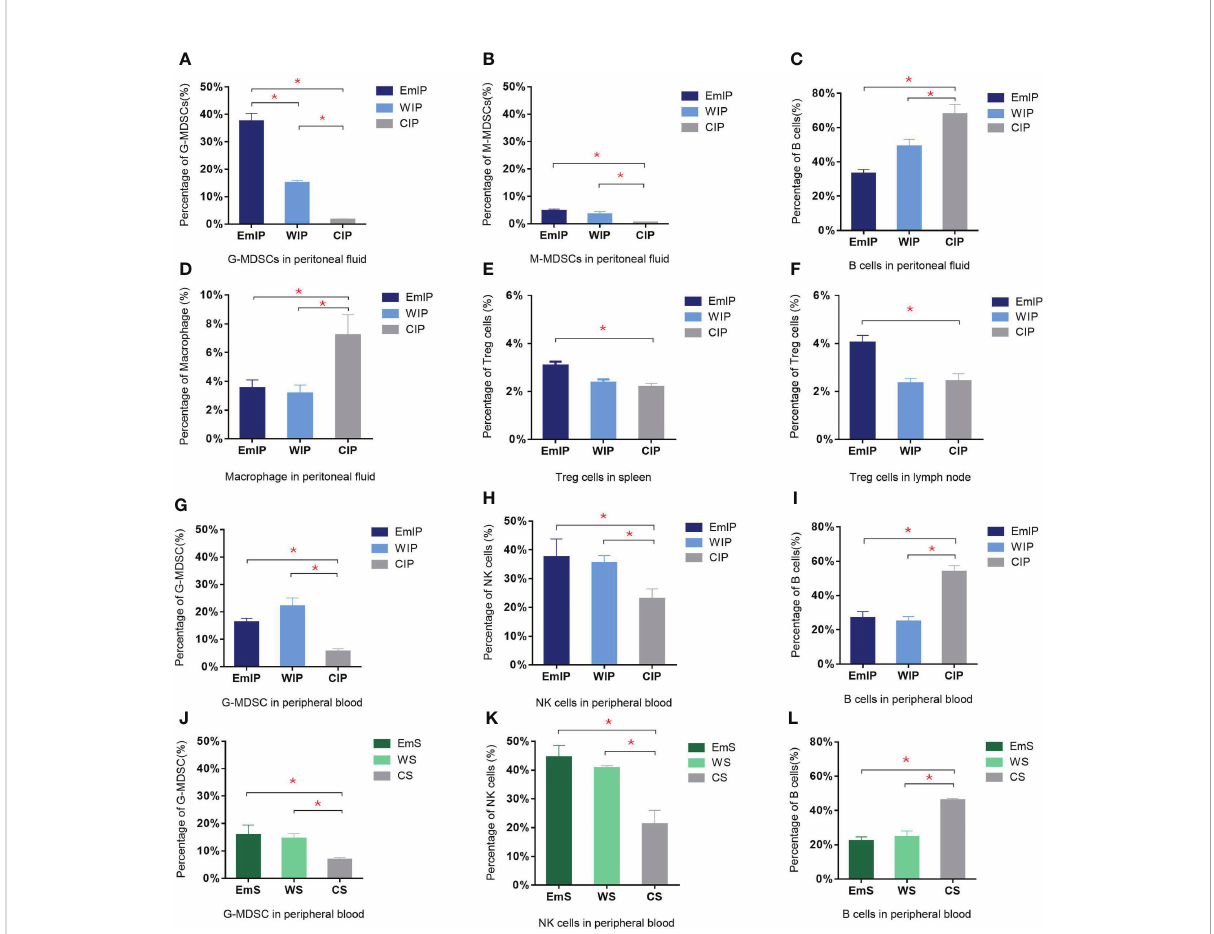
FIGURE 5 Changes in immune cells in peritoneal fl uid, peripheral blood, spleen, and lymph node of endometriosis mice. There were signi fi cant increases in both granulocytic and monocytic myeloid-derived suppressor cells (G-MDSC and M-MDSC) but a decrease in B cells and macrophages in intraperitoneal injection group in peritoneal fl uid (A – D) . Increase in G-MDSC and NK cells and decrease in B cells were found in both intraperitoneal injection (G – I) and subcutaneous transplantation (J – L) groups in peripheral blood. Signi fi cant increase in Treg cells in endometrium intraperitoneal injection group in spleen (E) and lymph node (F) . IP, intraperitoneal injection; S, subcutaneous transplantation; EmIP, endometrium intraperitoneal injection. Data are shown as mean ± SEM, n = 5, for each group. * p < 0.05 by ANOVA. EmIP, endometrium fragments and intraperitoneal; WIP, whole uterus tissue and intraperitoneal; CIP, sham control and intraperitoneal; EmS, endometrium fragments and subcutaneous; WS, whole uterus tissue and subcutaneous; CS, sham control and subcutaneous; G-MDSC, granulocytic myeloid- derived suppressor cells; M-MDSC, monocytic myeloid-derived suppressor